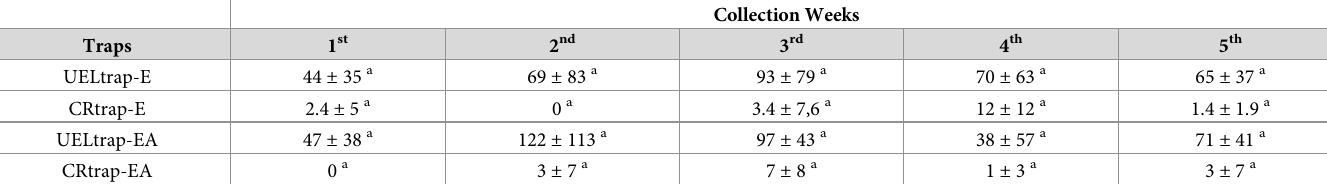
Table 2. The average and standard deviation of the Aedes obtained in each trap from March to April 2017 in Londrina, Parana´, Brazil.